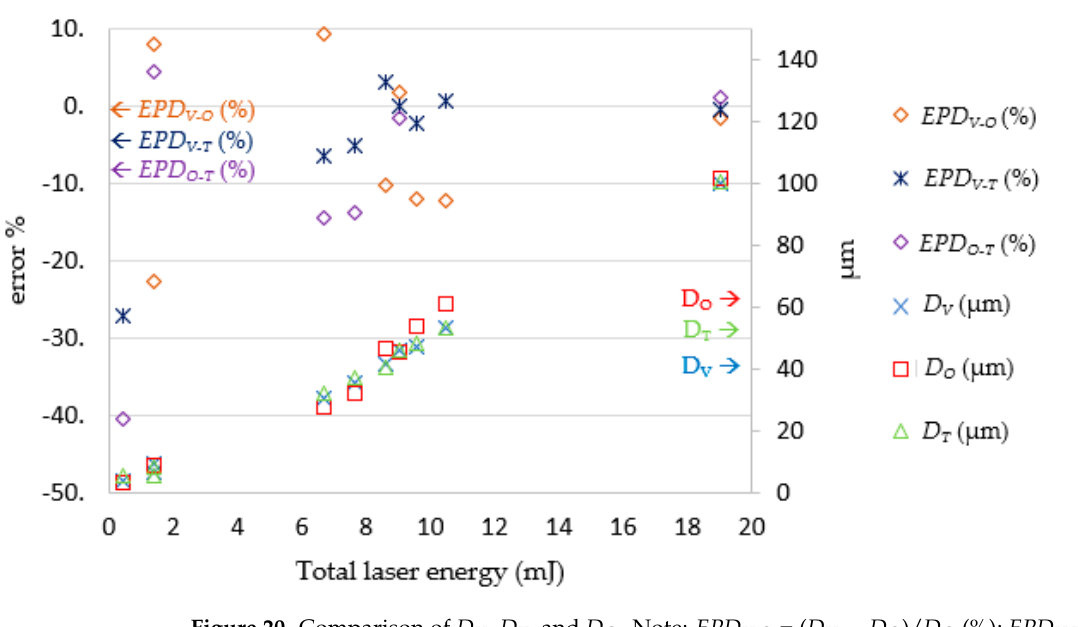
Figure 20. Comparison of D V , D T , and D O . Note: EPD V-O = ( D V − D O )/ D O (%); EPD V-T = ( D V − D T )/ D T (%); EPD O-T = ( D O − D T )/ D T (%).